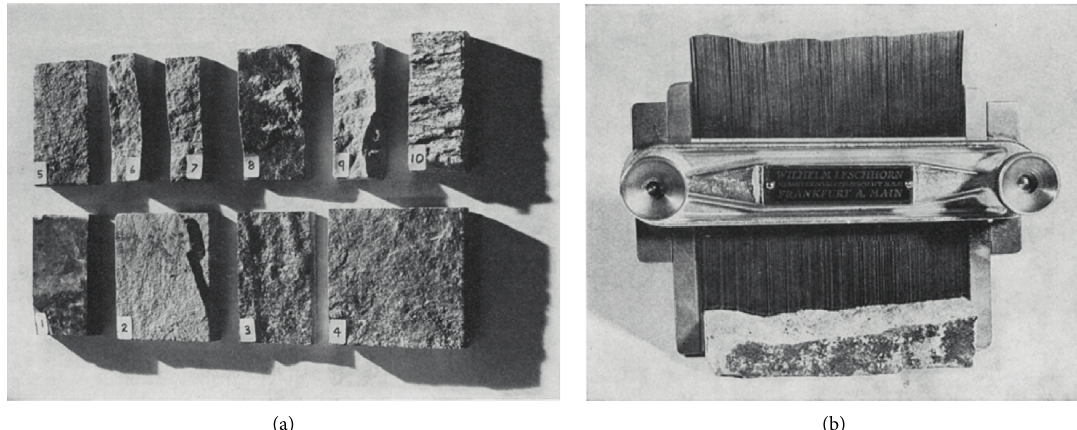
Figure 3: Procedure of using a profile comb to get a profile from the joint surface. (a) 10 typical joint surfaces. (b) Profile comb [8, 9].